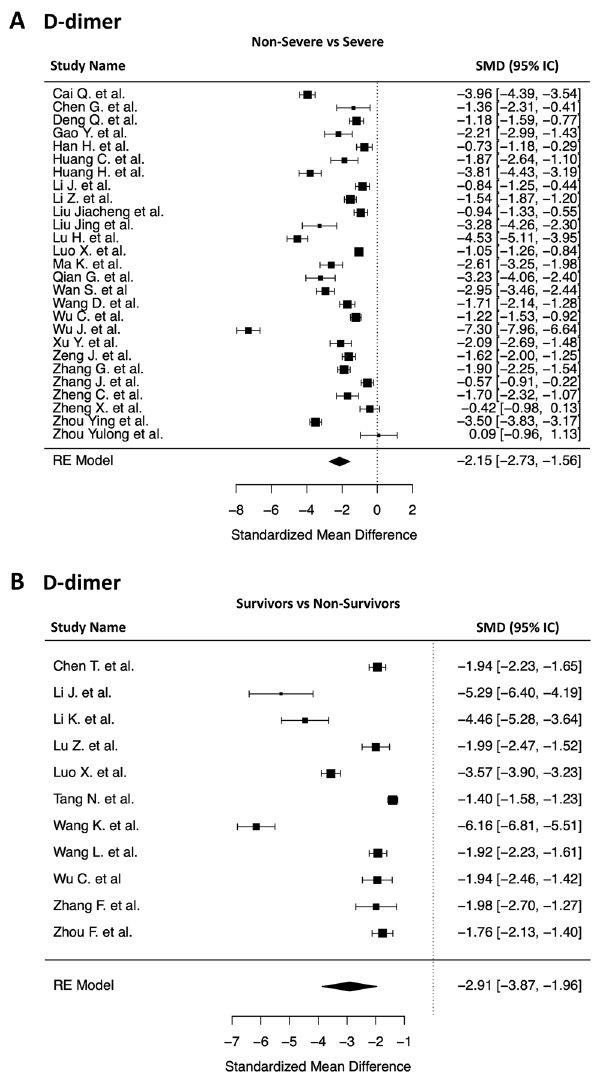
Figure 3. Forest plots of the standardized mean difference in d-dimer levels. ( A ) Non severe vs Severe patients. The black squares represent the pooled standardized mean difference effect size for each analysis while the left and right extremes of the squares represent the corresponding 95% confidence intervals for the pooled standardized mean difference effect size for each analysis. All analyses are based on a random-effects model. ( B ) Survivors vs Non-Survivors. The black squares represent the pooled standardized mean difference effect size for each analysis while the left and right extremes of the squares represent the corresponding 95% confidence intervals for the pooled standardized mean difference effect size for each analysis. All analyses are based on a random-effects